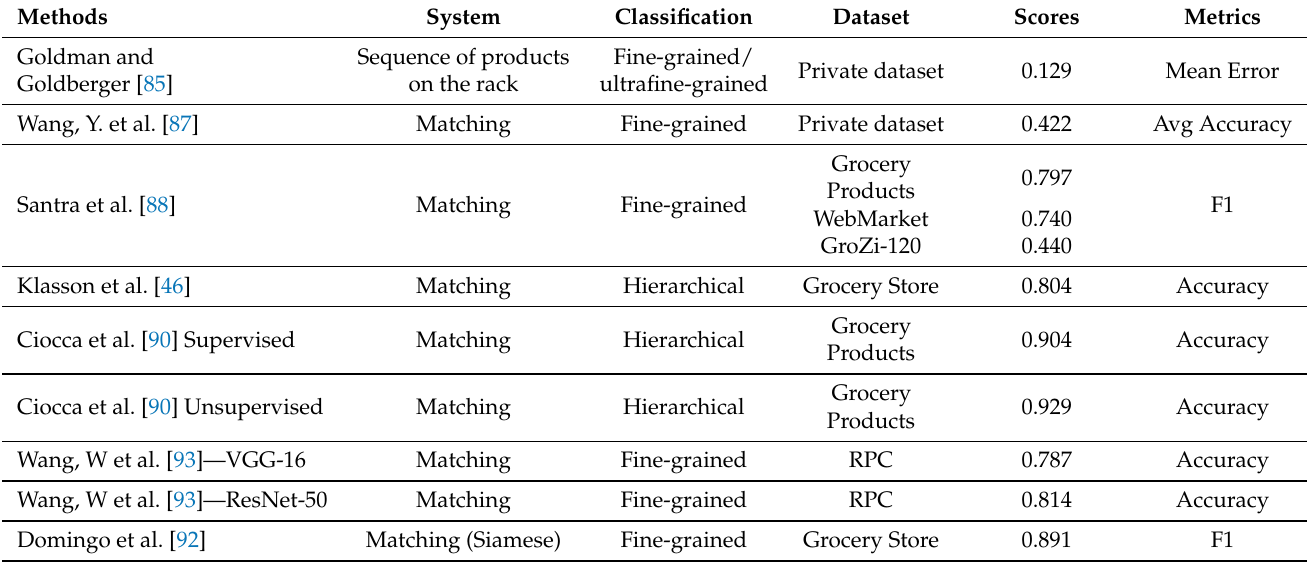
Table 5. Comparison of grocery product recognition